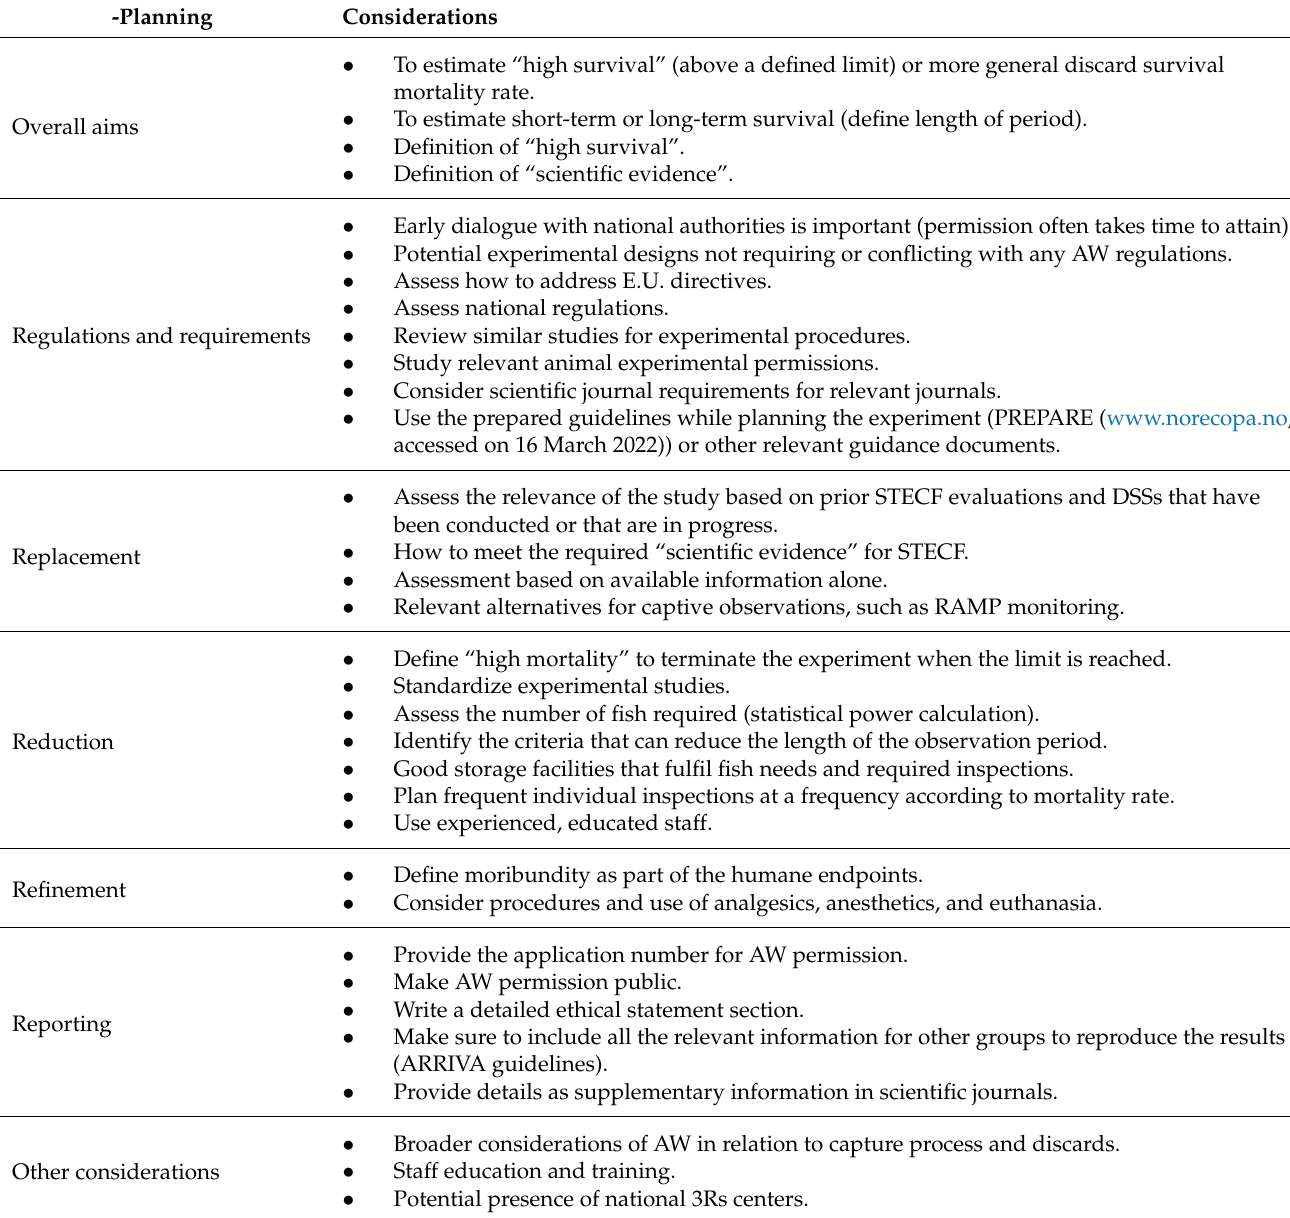
Table 3. Considerations when conducting